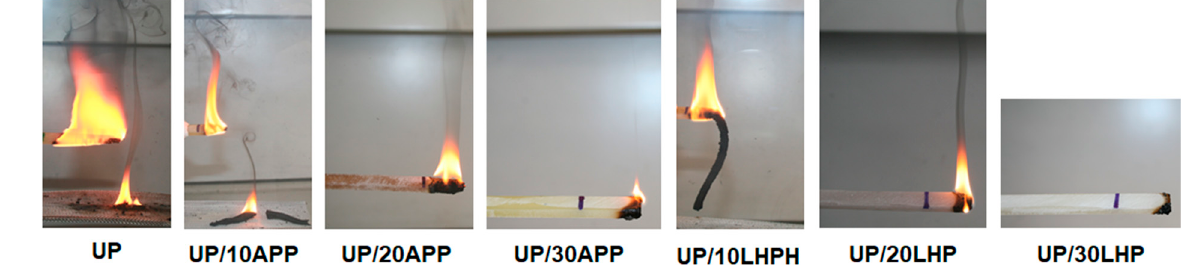
Figure 6. Photographs of the UP and UP/IFRs during the horizontal burning tests.